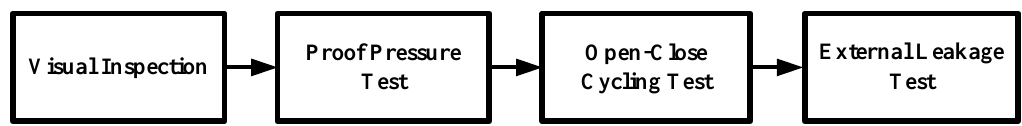
Figure 17. Flow chart showing the sequential acceptance tests performed on Fill and Vent Valves (FVVs) produced for the Adelis-SAMSON nano-satellites.